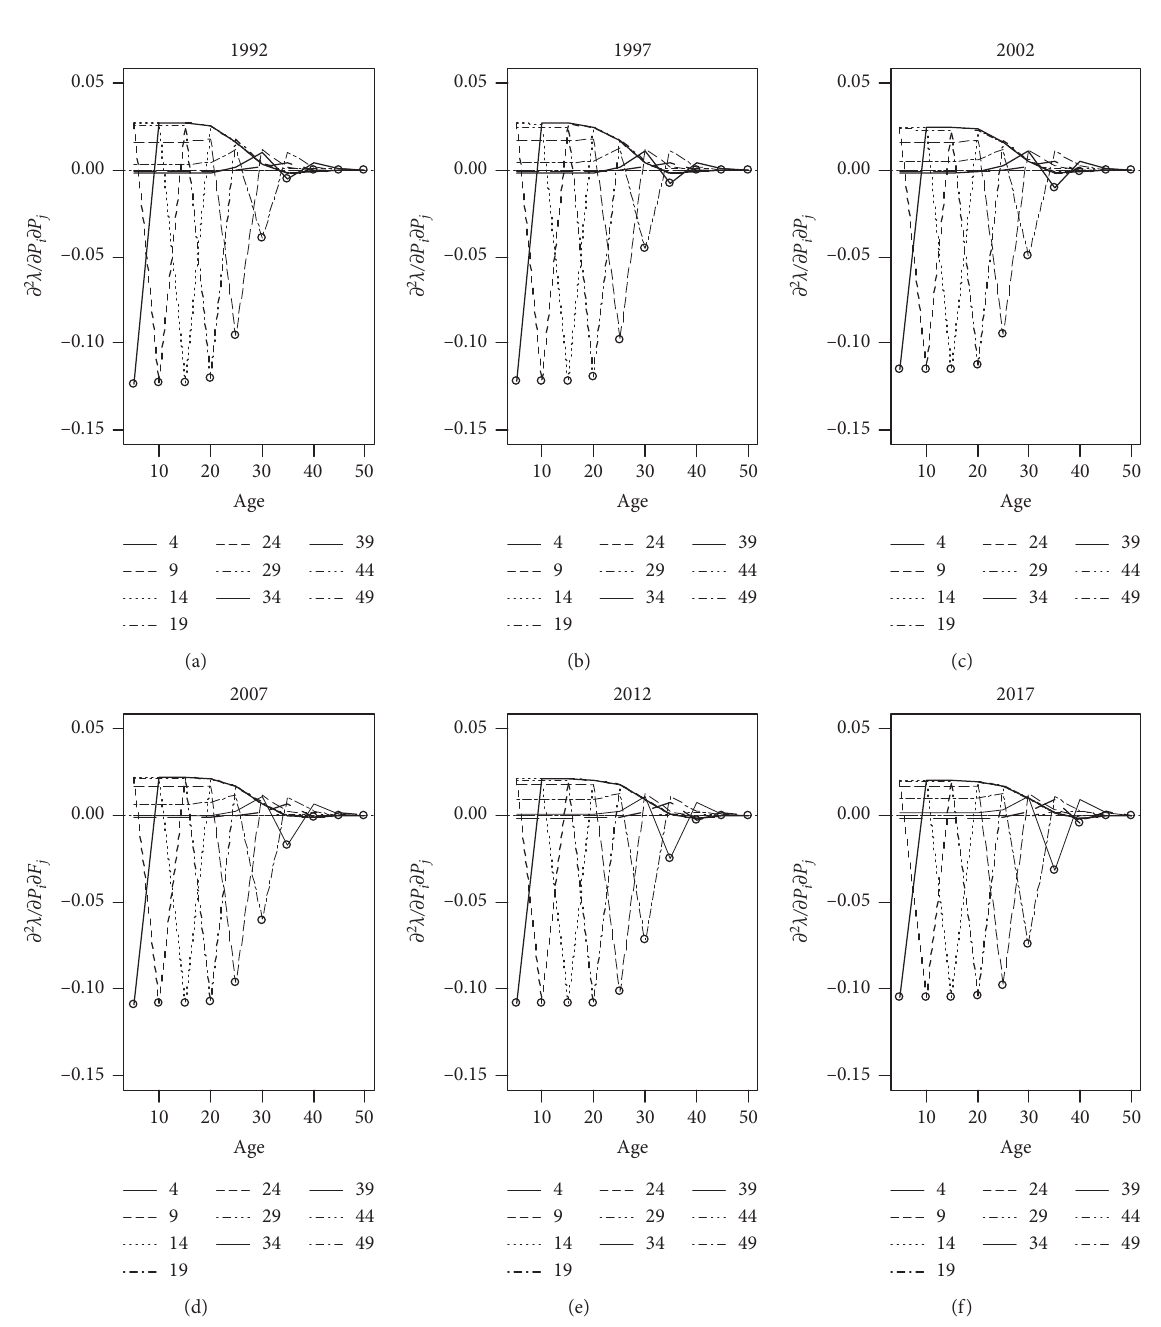
Figure 9: PGR second derivatives with respect to pairs of survival